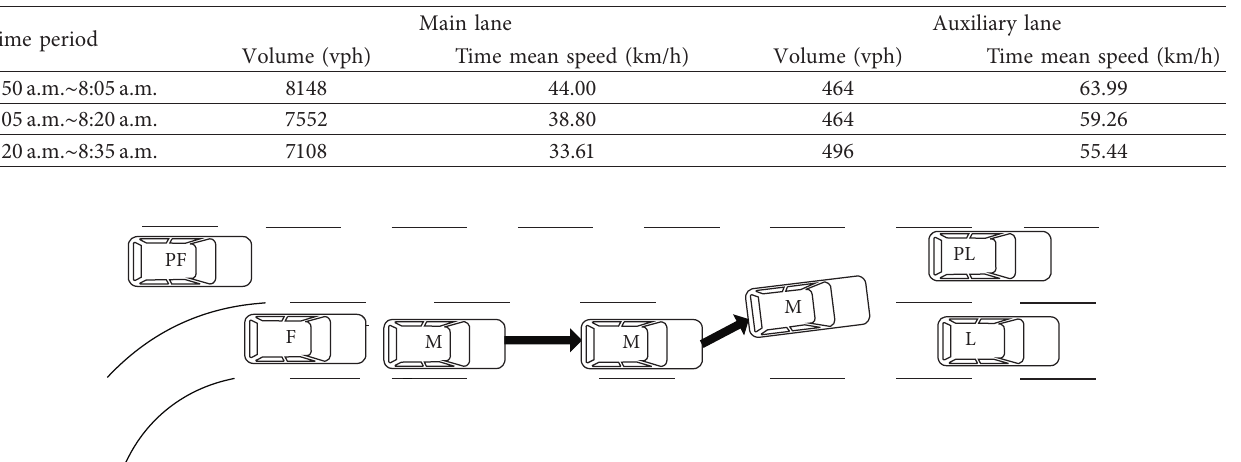
Figure 2: Schematic diagram of U.S. Highway 101. Table 1: Aggregate statics of three subsets.